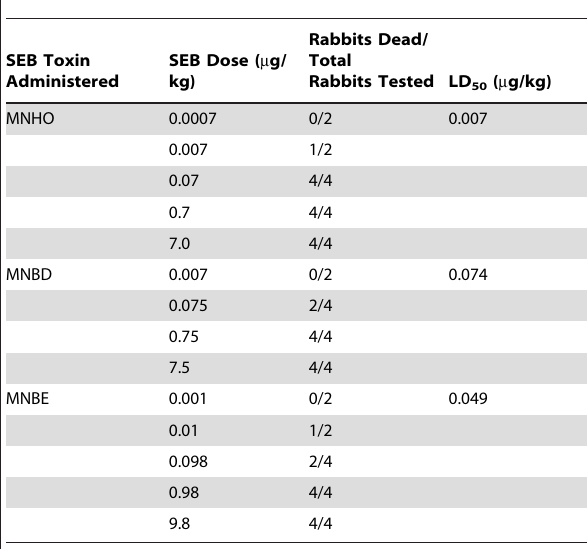
Table 1. LD 50 determination of variant